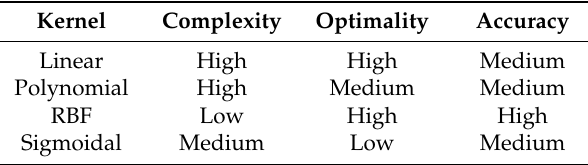
Figure 1. Non-linearization (Source: Introduction to Statistical Machine Learning, MIT Press, Cambridge, MA, USA, 2012 [7]). Table 2. Performance measures of SVM kernels.